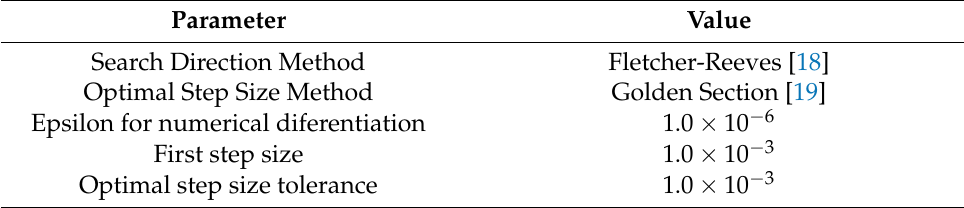
Table 2. Parameters of the conjugate gradient